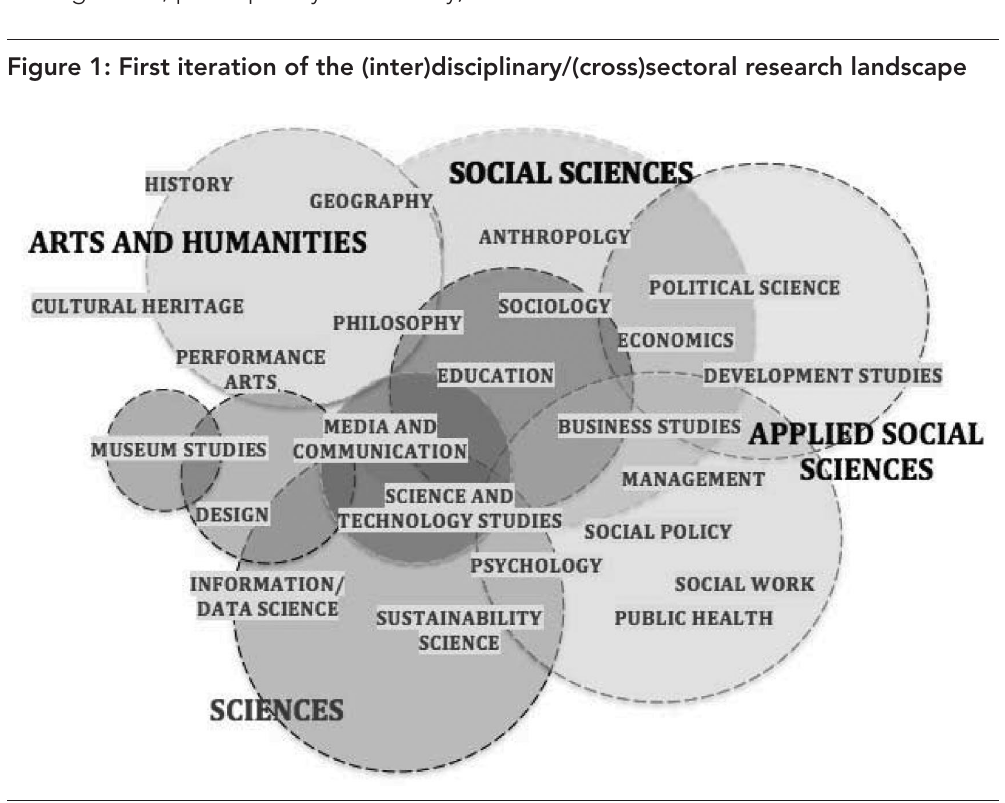
This landscape helped to frame the review and provide prompts for literature